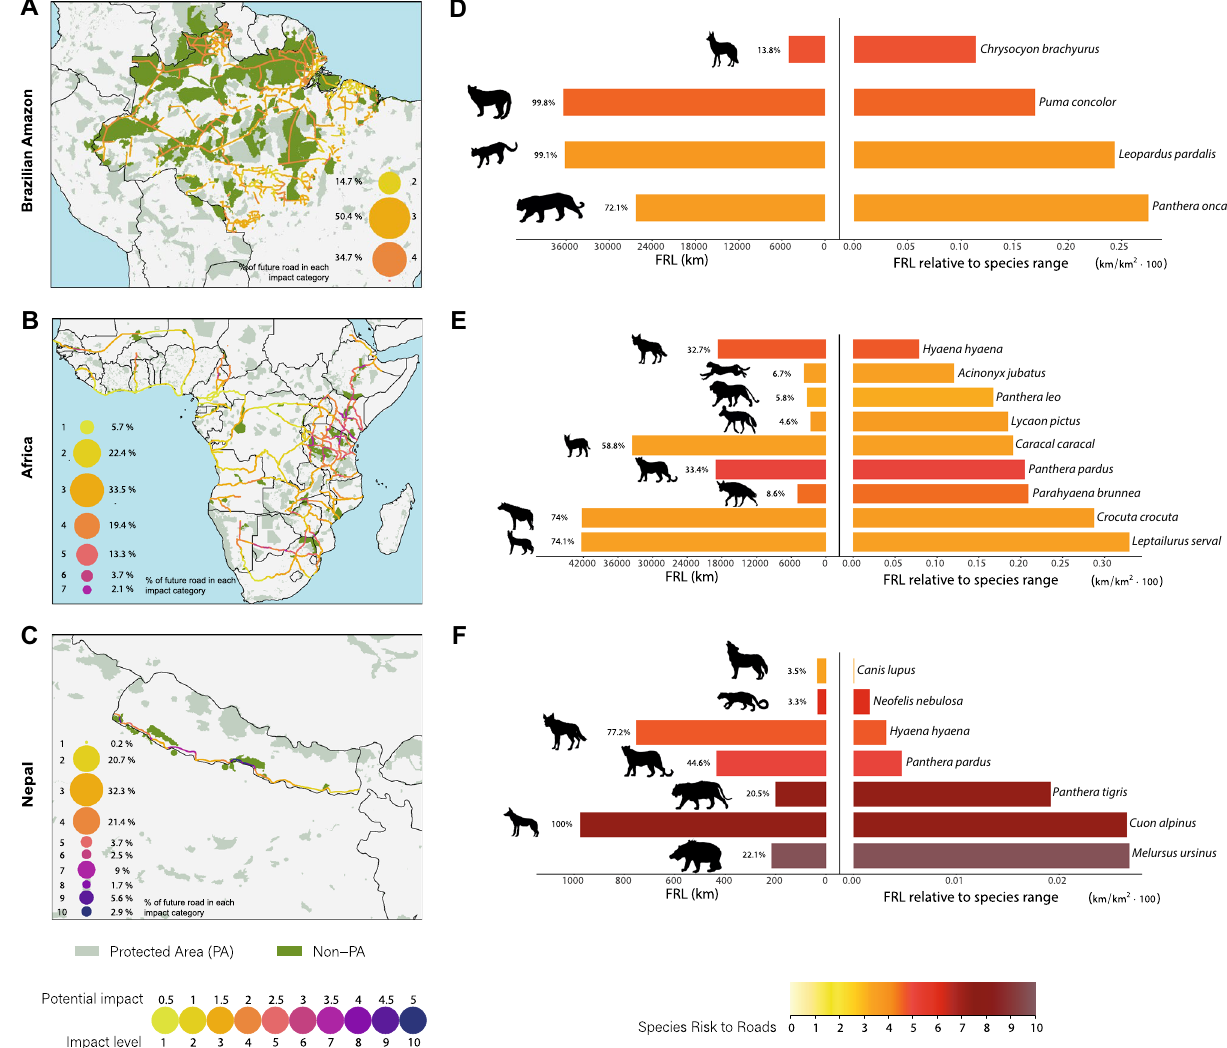
Figure 4. Potential impact of future road developments in ( A ) the Brazilian Amazon, ( B ) Africa, and ( C ) Nepal. Bubble sizes indicate the percentage of road length under each level of impact. Green areas denote protected areas 48 , and in darker green are the areas that will be intersected directly or within a 10-km buffer around proposed roads. Bar graphs indicate the potential impact of future road developments on predator species present in ( D ) the Brazilian Amazon, ( E ) Africa, and ( F ) Nepal. Bars on the left show the length (km) of future roads that will cross the species distribution range; numbers beside the bars indicate the percentage in relation to the complete length of the future development. Bars on the right indicate the proportion of future road length crossing the species range in relation to the size of the species total distribution. FRL = Future Road Length. Colours in bars represent the road risk for each species calculated in our assessment. Maps